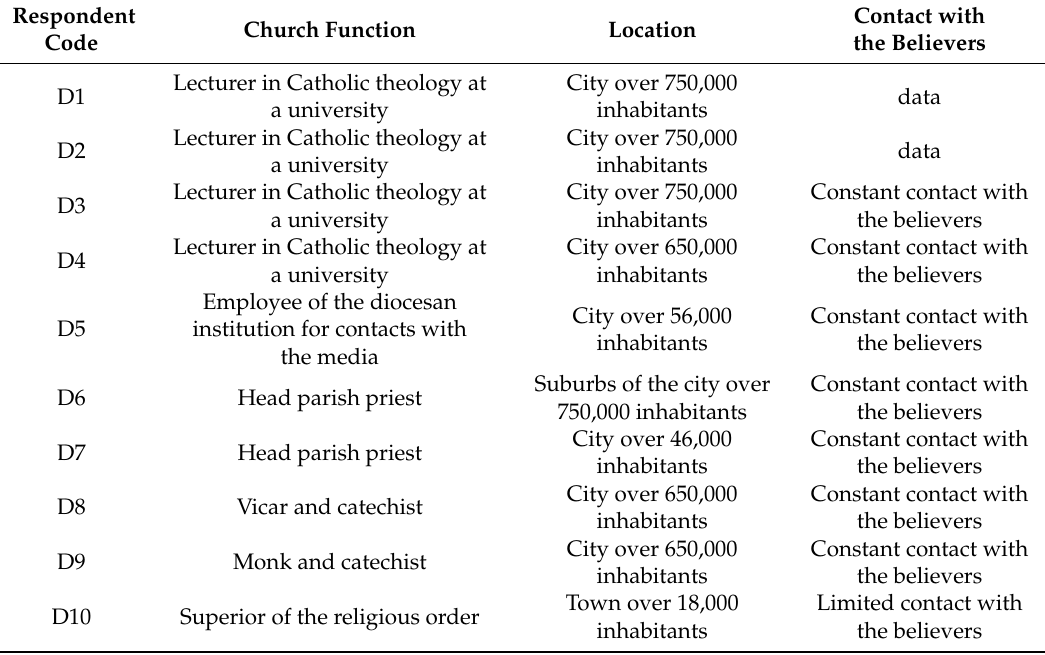
Table 1. Respondents participating in the